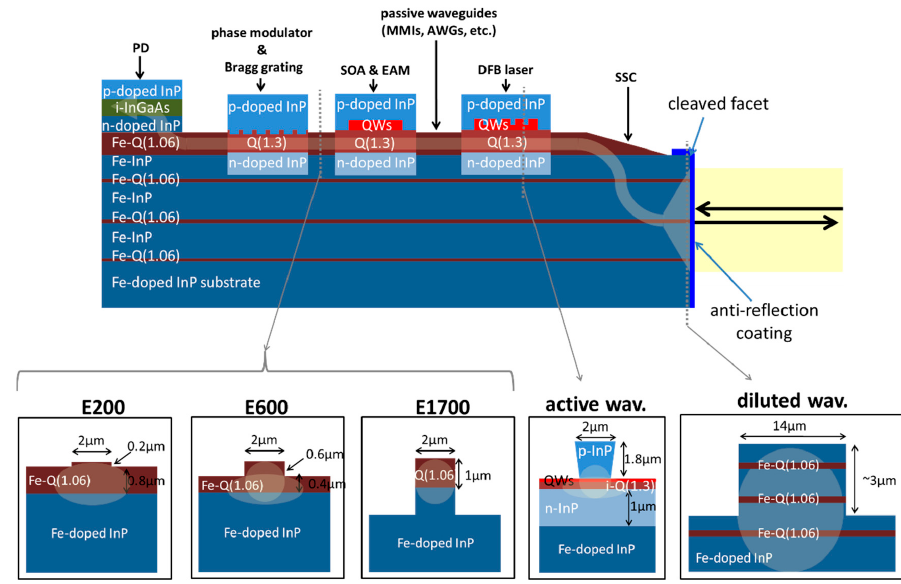
Figure 1. Schematic showing the epitaxial layers of the generic foundry process along the propagation direction, and the insets show cross-sections of the various waveguides. The purpose of the diluted